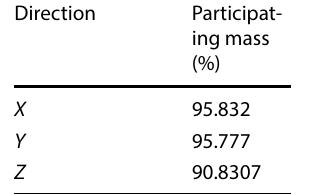
Table 4 Total modal mass